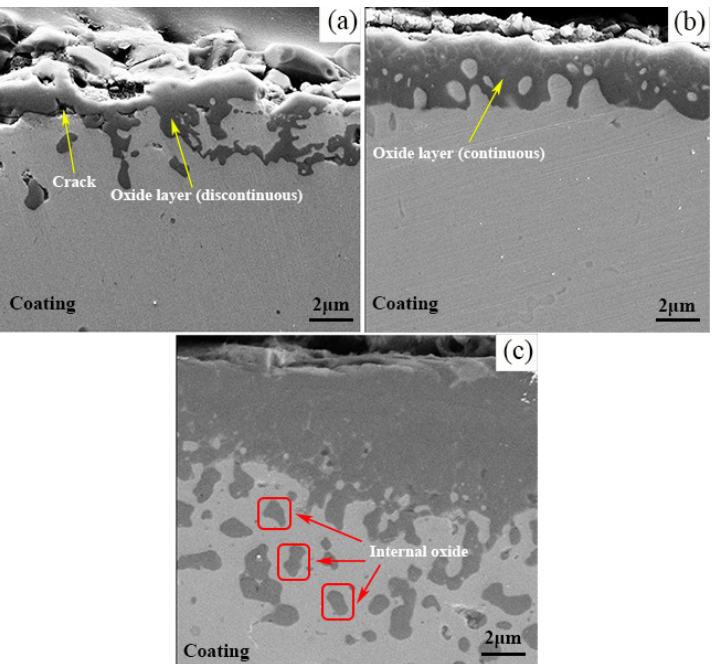
Figure 7. SEM images of TS-PC Y-modified ( a ) NiCrAl; ( b ) NiCrAl0.5Y and ( c ) NiCrAl1.0Y coatings after oxidation at 1100 ° C for 100 h.